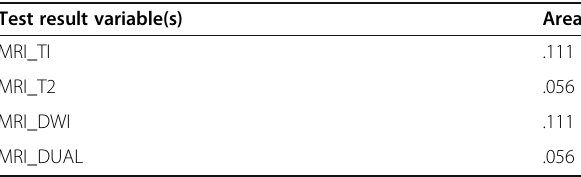
Table 4 Area under the